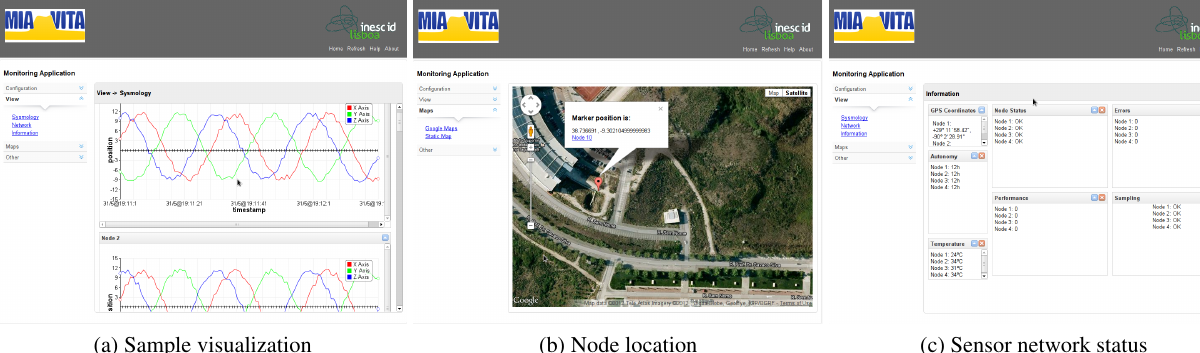
Fig. 7: Monitoring application screenshots Table 2: Technical specification — external components